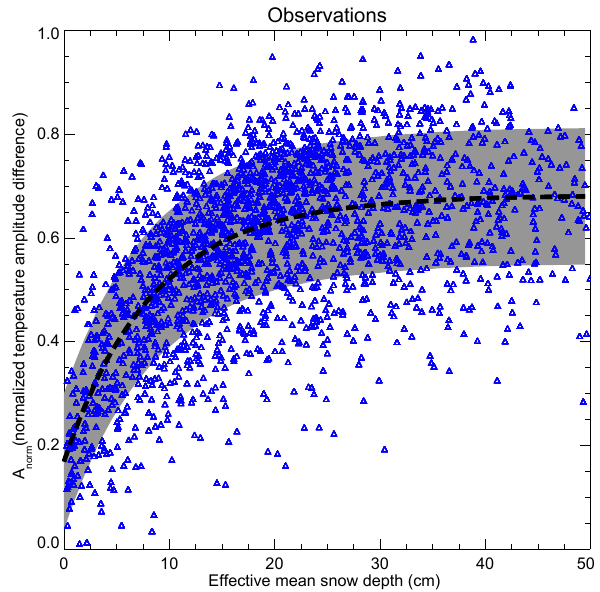
Figure 3. Observed relation between A norm and effective mean snow depth ( S depth , eff ) along with the resulting exponential fit (dashed line). The grey shading shows the median fit plus/minus the mean scatter ( O err ) of all